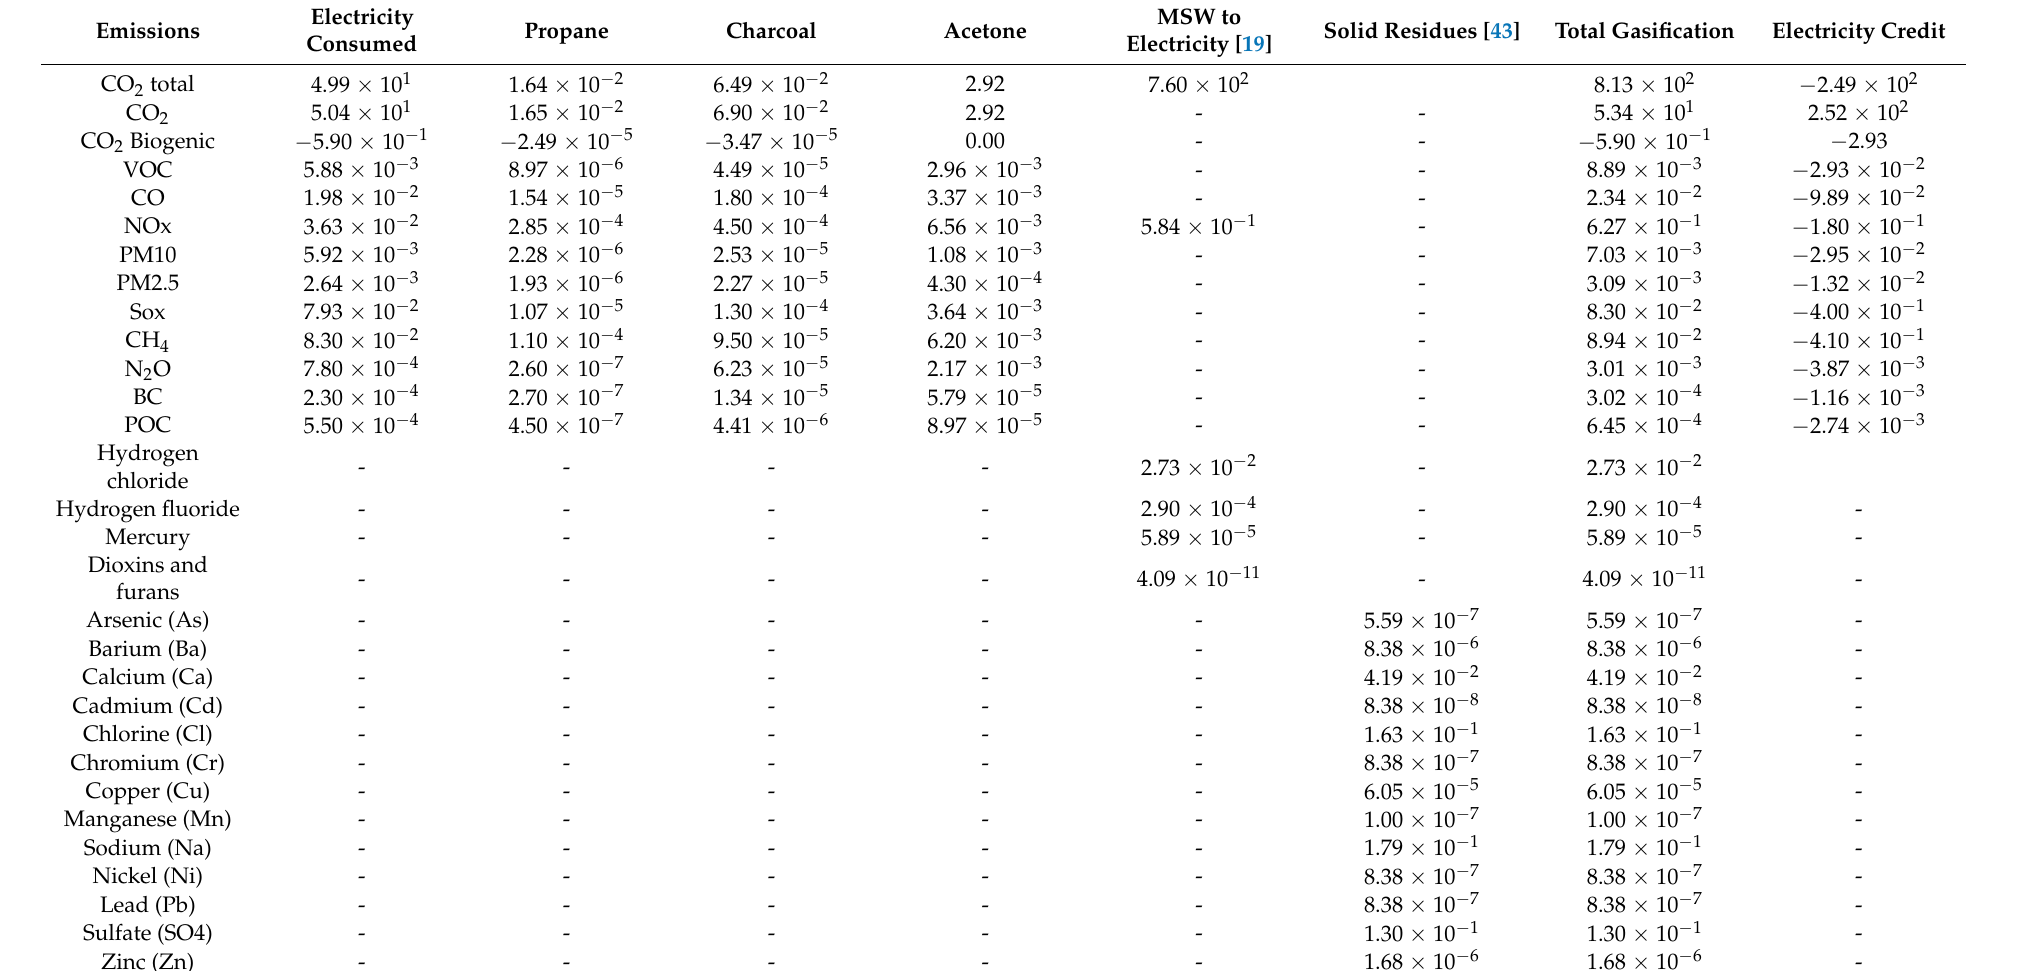
Table 4. Emissions output (in kg) of MSW gasification using